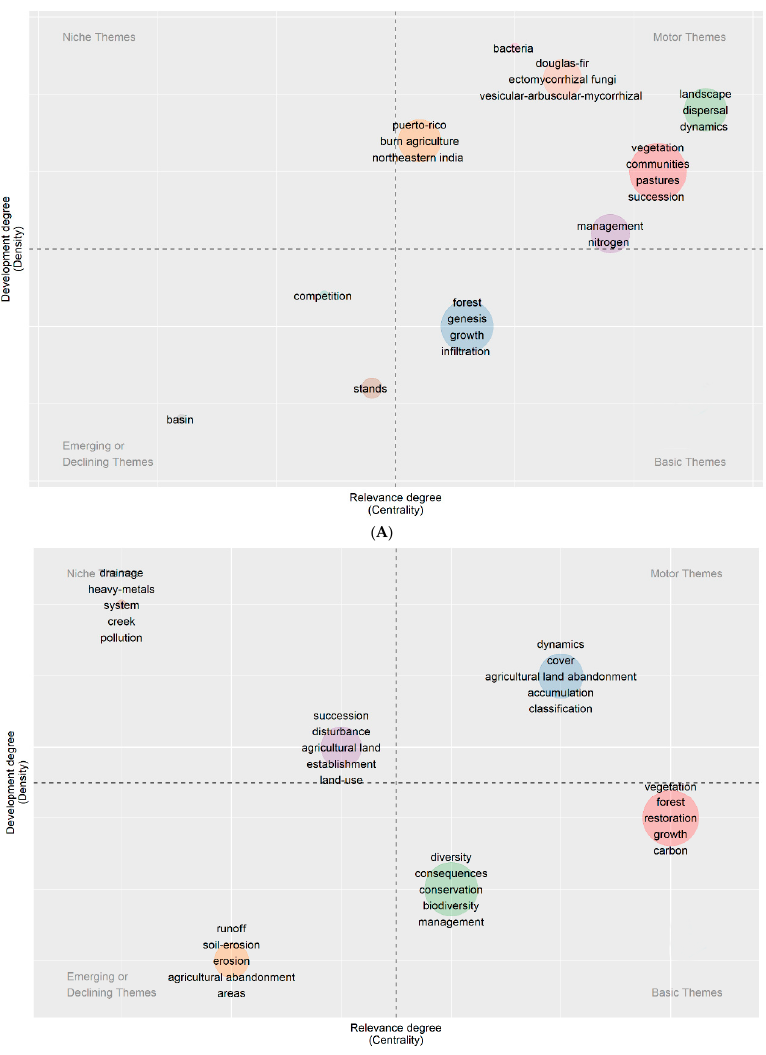
Figure A2. Multiple correspondence analysis of keywords in the field of farmland abandonment. Int. J. Environ. Res. Public Health 2022 , 19 , x FOR PEER REVIEW